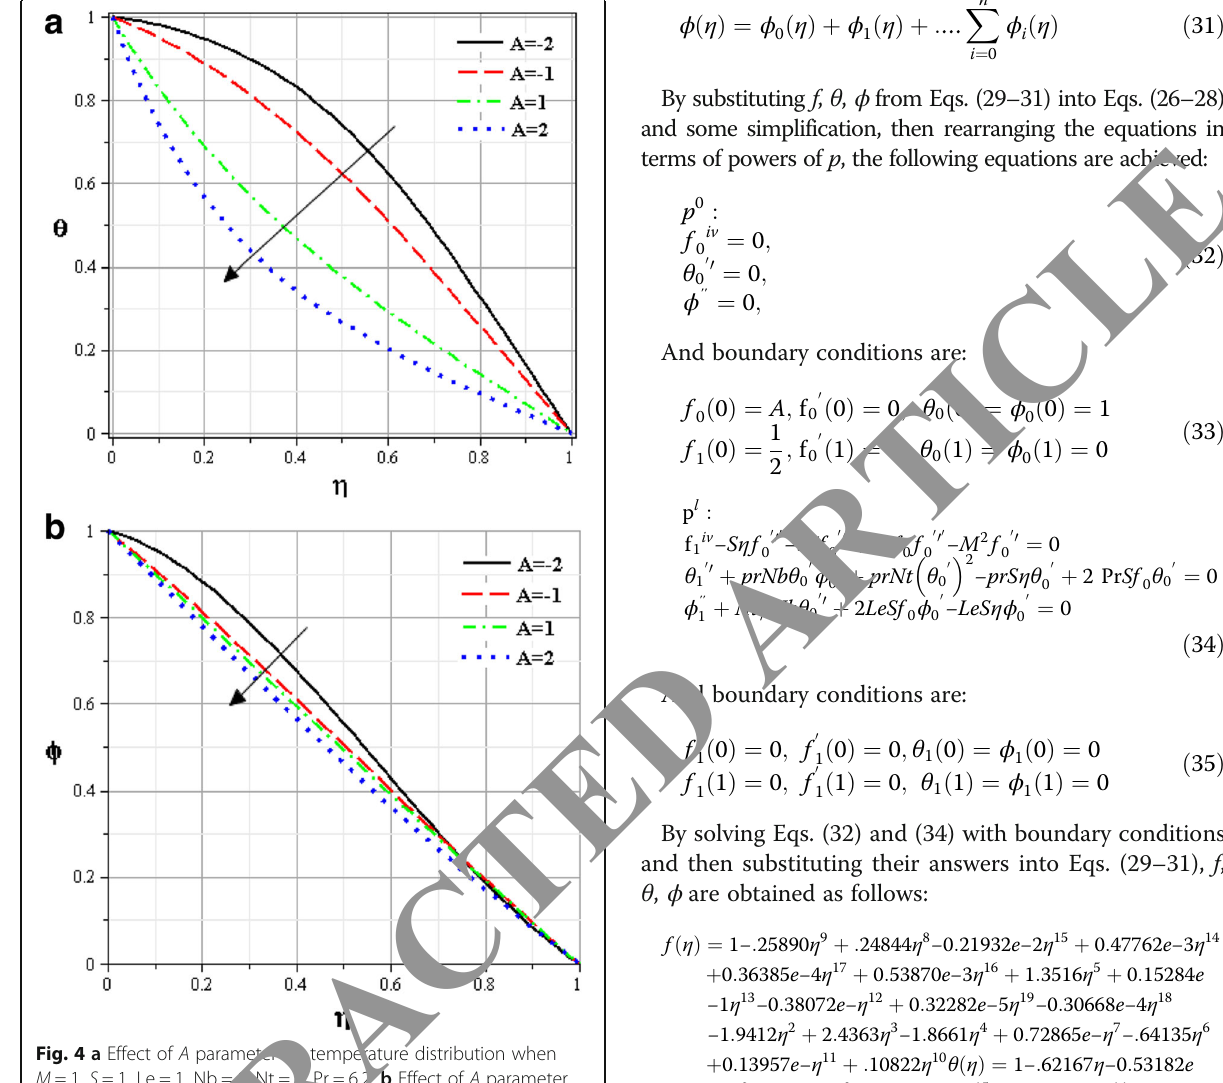
Fig. 4 a Effect of A parameter on temperature distribution when M = 1, S = 1, Le = 1, Nb = 1, Nt = 1, Pr = 6.2. b Effect of A parameter on concentration distribution when M = 1, S = 1, Le = 1, Nb = 1, Nt = 1, Pr =